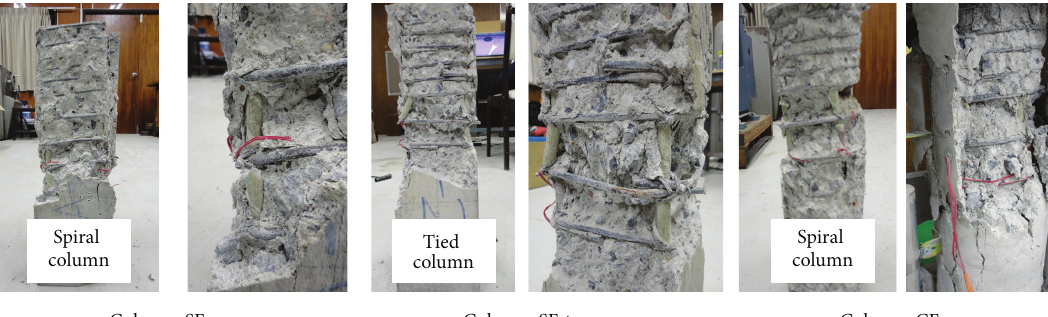
Figure 6: Failure modes of GFRP columns.